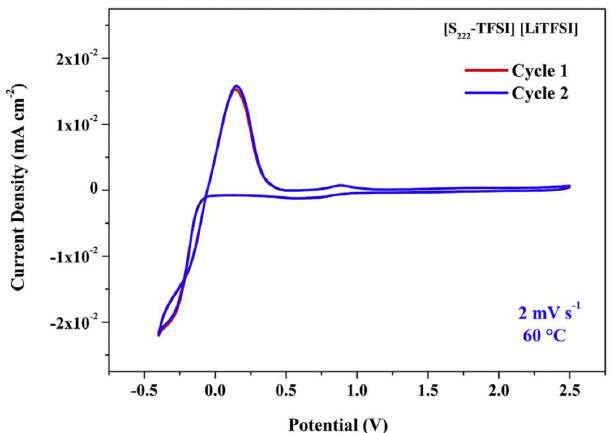
Figure 18. Cyclic voltammetric measurements of the [S 222 ][NTf 2 ]-LiNTf 2 IL electrolyte. Reproduced with permission from [76], copyright 2019, Elsevier.